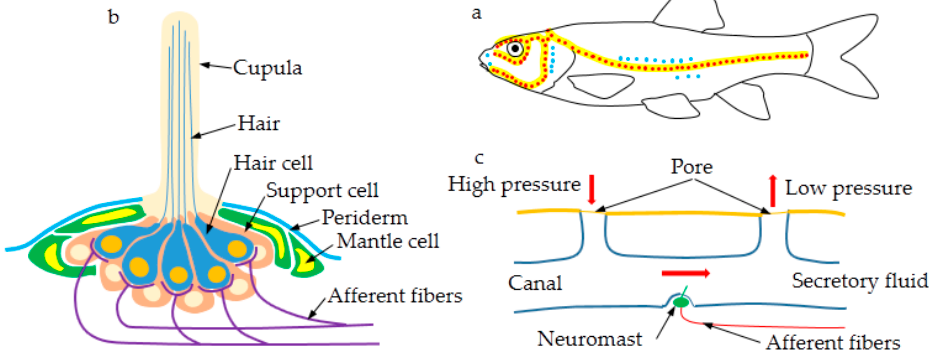
Figure 2. Brief introduction of a fish’s lateral line [28]. ( a ) Distributions of superficial neuromasts (blue dots) and canal neuromasts (red dots); ( b ) The microstructures of an individual neuromast; ( c ) A canal neuromast located in a fluid-filled lateral-line canal.